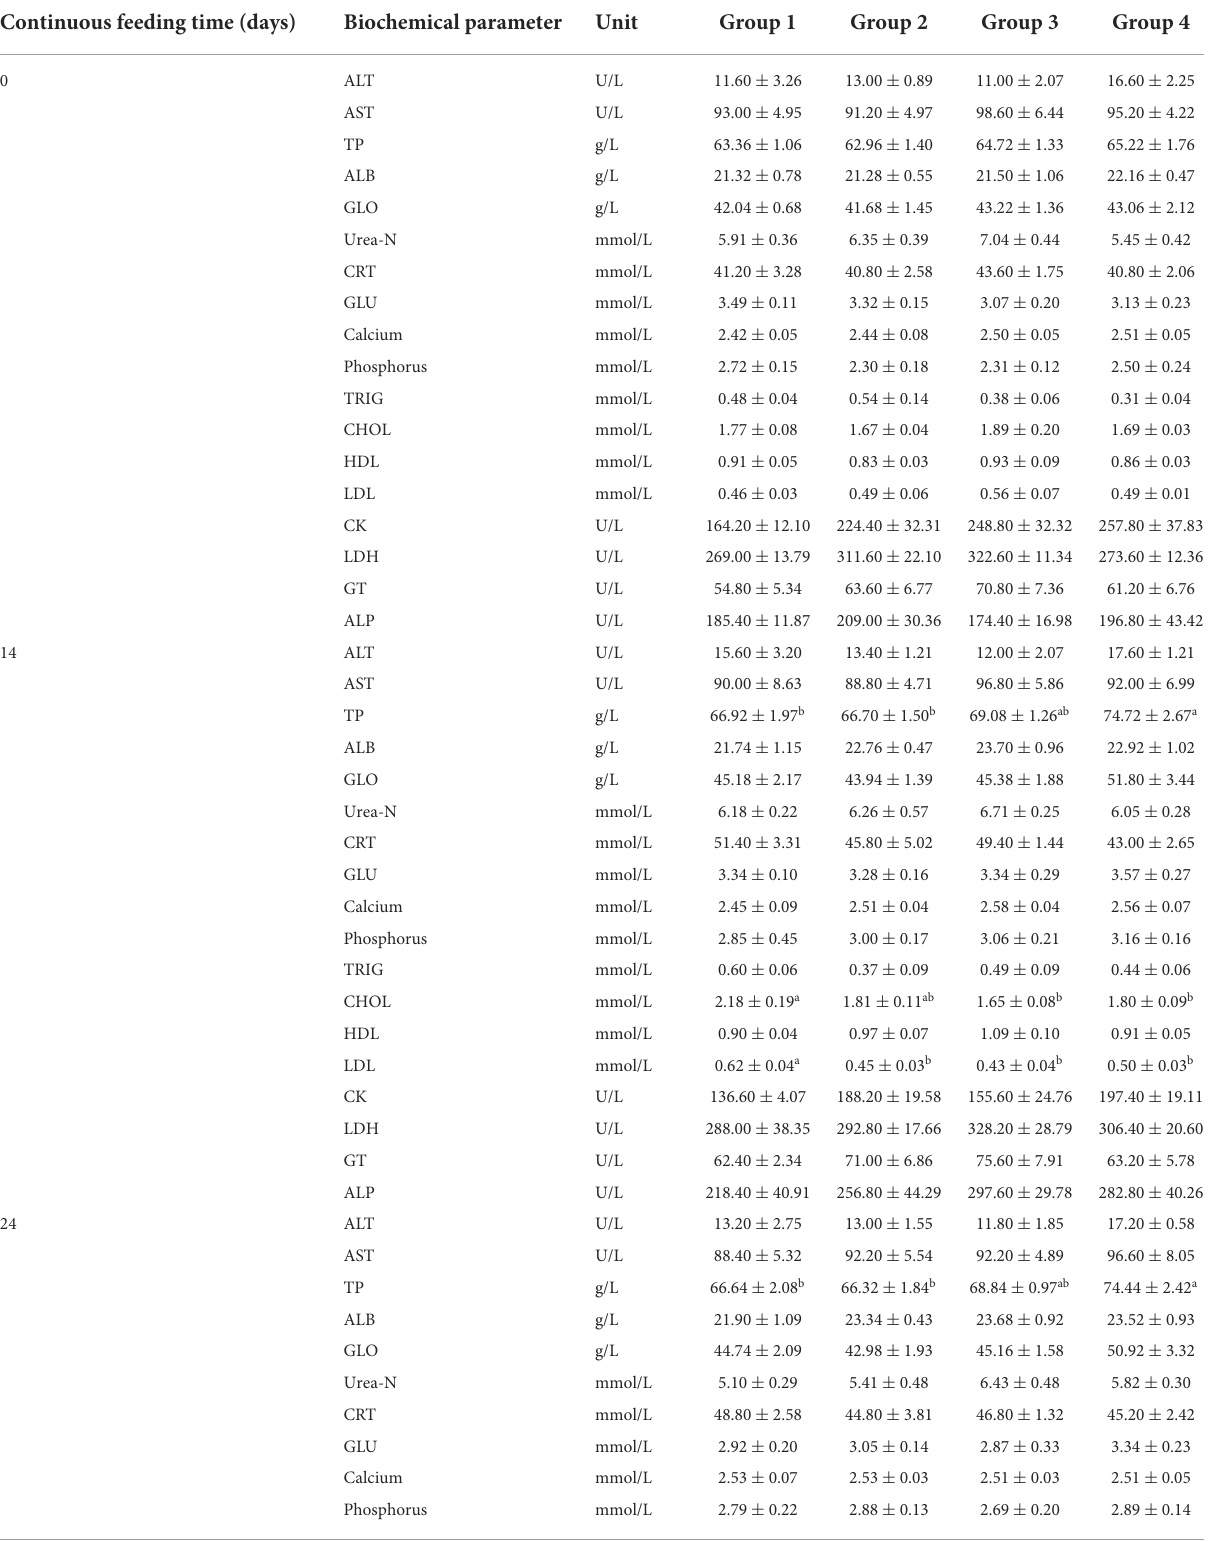
TABLE 4 Comparison of serum biochemical parameter levels (mean ± SE) among four treatment groups (n = 5 in each group) after 0 (before feeding), 14, 24, and 40 consecutive days of feeding. Continuous feeding time